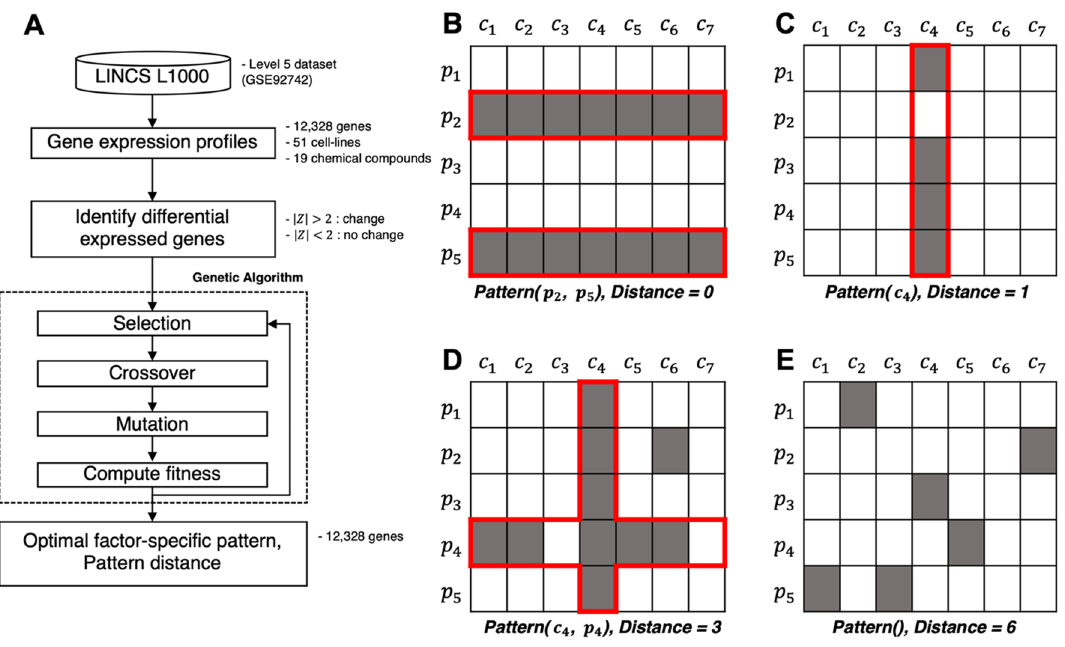
Figure 1. ( A ) Workflow schema of FacPat. For our analysis, the gene expression profiles of 51 cell lines treated with 19 chemical compounds from the L1000 dataset were constructed. The threshold β > 2 was used to identify differentially expressed genes (DEGs) in the expression profile. The optimal biological factor-specific patterns are identified by a genetic algorithm. ( B – D ) The optimal factor-specific pattern (red line) and pattern distance (d) from the expression profile using a genetic algorithm. The gray color shows identified DEGs. ( B ) The β - and E ij -specific pattern (d = 0). ( C ) The E ′ E ij − E ′ - and c 4 -specific pattern ij (cid:30) ij -specific pattern (d = 1). ( D ) The (cid:31)(cid:30) (cid:30) (cid:30) (d = 3). ( E ) The null pattern (d = 6). In binary space, pattern distance is defined as the count of mismatches. c 4 , (cid:30) (cid:30) the i th cell line; p 4 , the i th